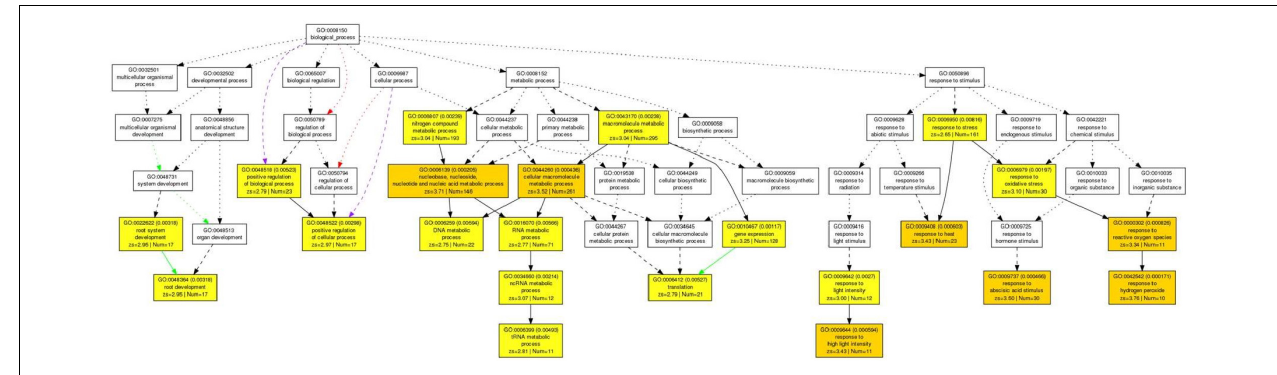
FIGURE 6 | Parametric analysis of gene set enrichment (PAGE) in the biological process of 1,945 genes in cassava plants treated with 10 mM acetic acid in comparison to cassava plants treated with water treatment as determined with agriGO software. The genes that were annotated based on homology with Arabidopsis were selected by Westfall-Young multiple testing correction (FDR < 0.0001). The first pair of numerals represents the number of genes in the input list associated with the GO term and the number of genes in the input list. The second pair of numerals represents the number of genes associated with the GO term in the Arabidopsis database (TAIR10), the total number of Arabidopsis genes with GO annotations in TAIR10 and the p -value in parenthesis. Box colors in PAGE indicate levels of statistical significance: yellow < 0.01; orange < 0.001. White boxes are shown as non-significant terms.